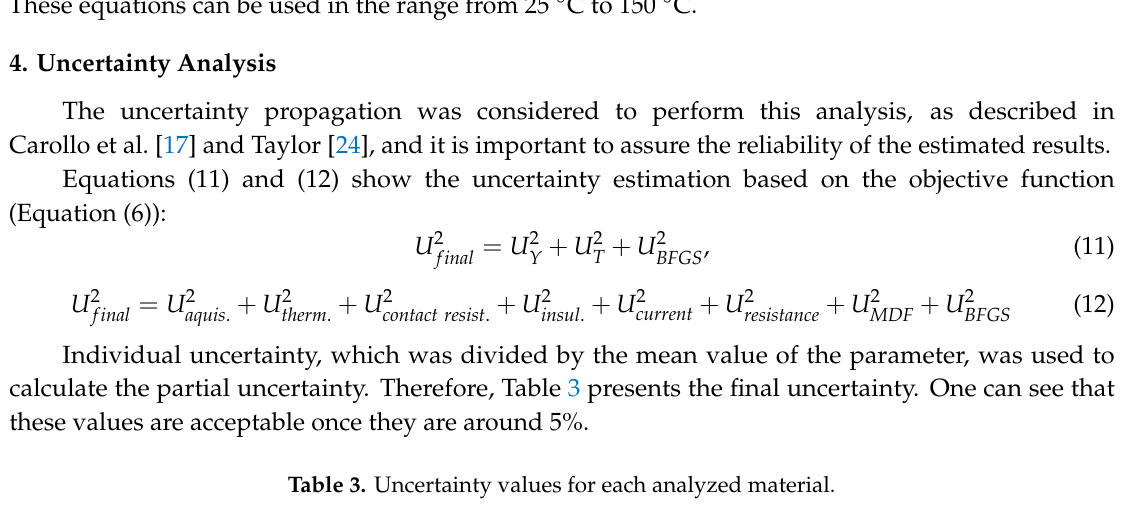
Figure 16. Comparison between the literature values with the estimated results of λ on the AISI 304 stainless steel sample.